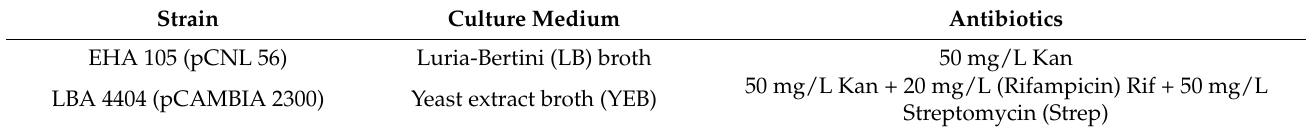
Table 1. Details of culture medium and antibiotics used for growth of different Agrobacterium tumefaciens strains.